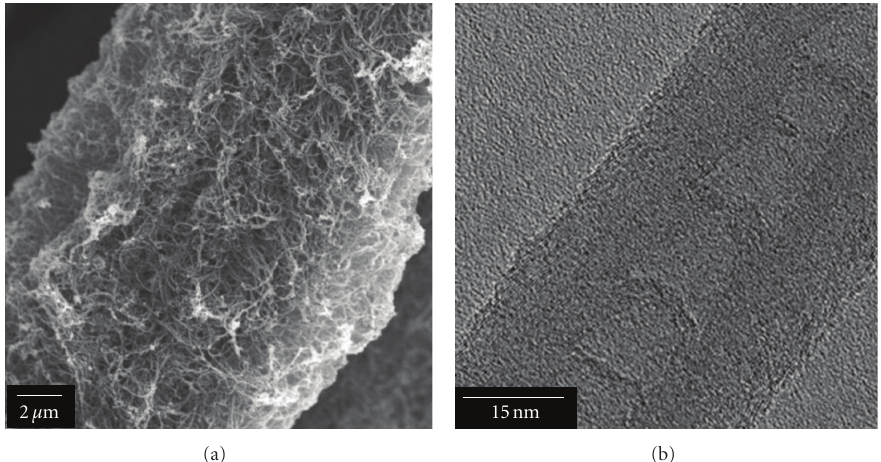
Figure 2: (a) FESEM images of pristine CNxNTs/CC current collector and (b) high-resolution TEM images of the Ni-catalyzed CNxNTs with bamboo-like